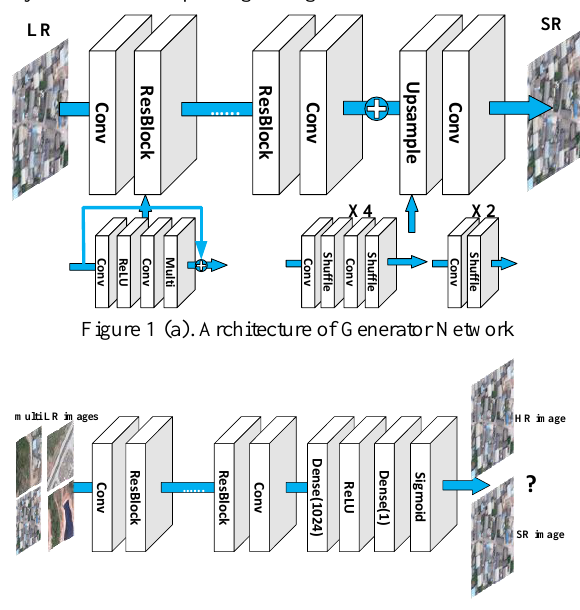
Figure 1 (b). Architecture of Discriminator